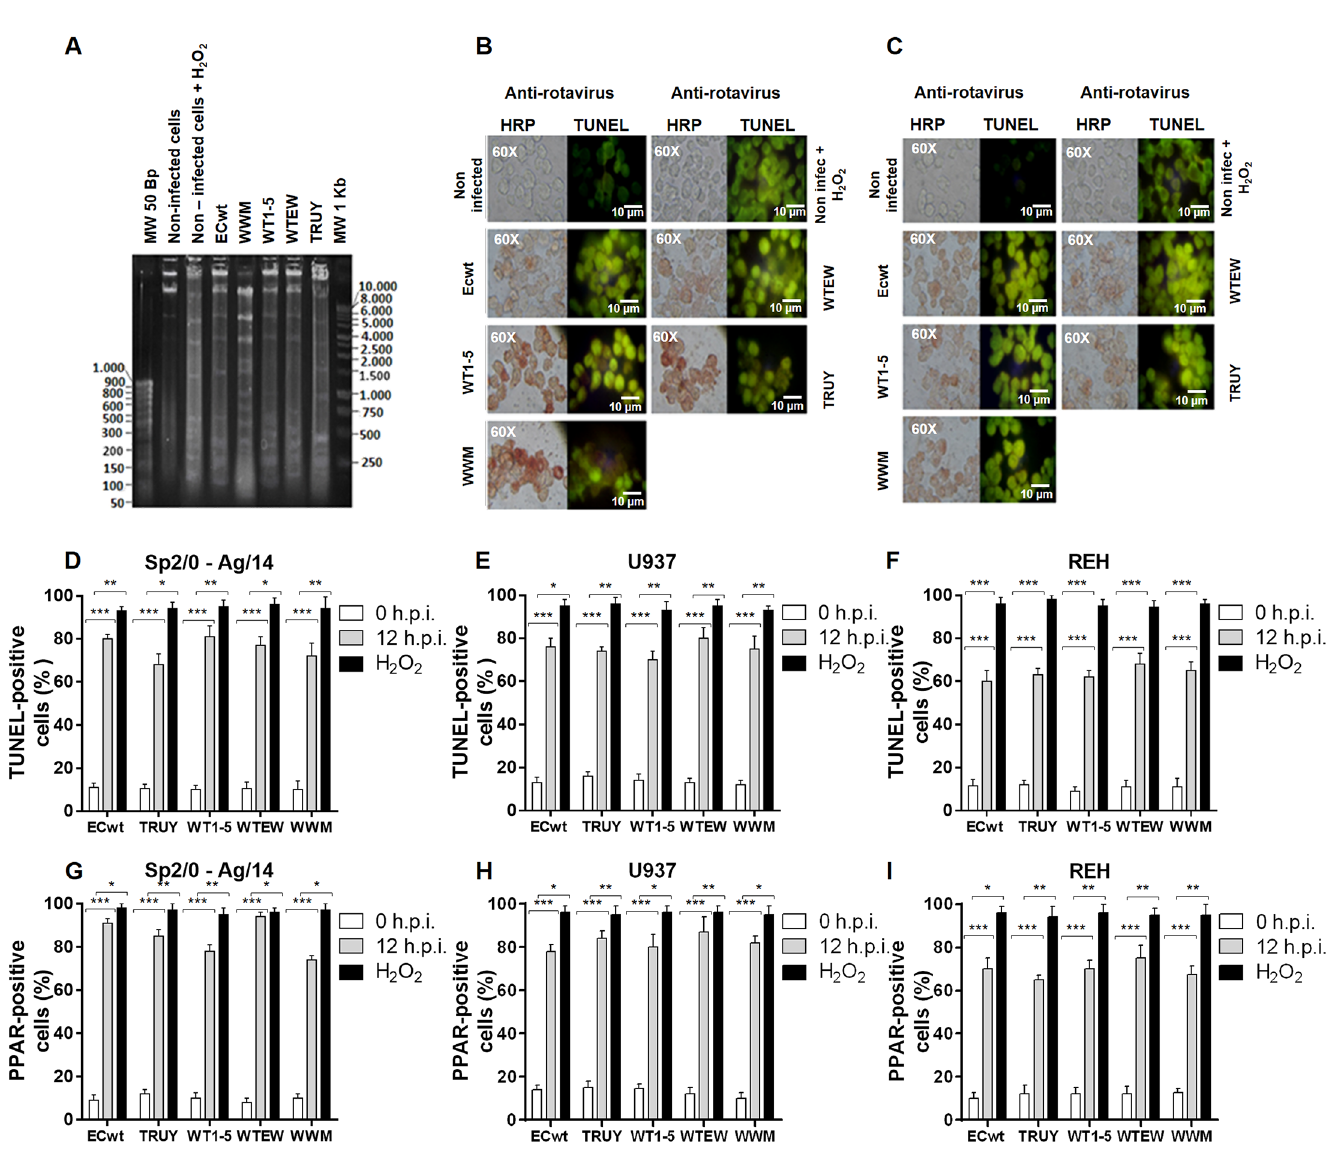
Fig 6. Nuclear fragmentation, DNA strand breaks and DNA repair induced by rotavirus infection. (A) Sp2/O-Ag14 cells were infected with tumor cell- adapted rotavirus isolates WTEW, TRUY, WT1-5, WWM or ECwt at a MOI of 2 and cells collected at 12 h.p.i. Phenol/chloroform extracted DNA was resolved in agarose gel (1%) electrophoresis and stained with ethidium bromide. H 2 O 2 -treated cells were used as a control. (B) Cells were infected with the virus indicated in (A) using a MOI of 0.8. Cells were examined for the presence of viral structural antigens using antibodies against SP in an immunochemistry assay (red) or cells were labeled for TUNEL and examined by immunofluorescence (green). (C) Cells were examined for the presence of viral antigens using antibodies against SP in an immunochemistry assay (red) or cells were incubated with antibodies against PARP (green). Uninfected cells and cells treated with H 2 O 2 (1 mM) for 12 h.p.i. were used as a control. (D, E and F) and (G, H and I) The percentages of TUNEL- and PARP-positive cells, respectively, were determined by immunofluorescence assay. Asterisks show statistically significant differences ( *** P < 0.001; ** P < 0.01; * P < 0.05). H 2 O 2 -treated cells were used as a